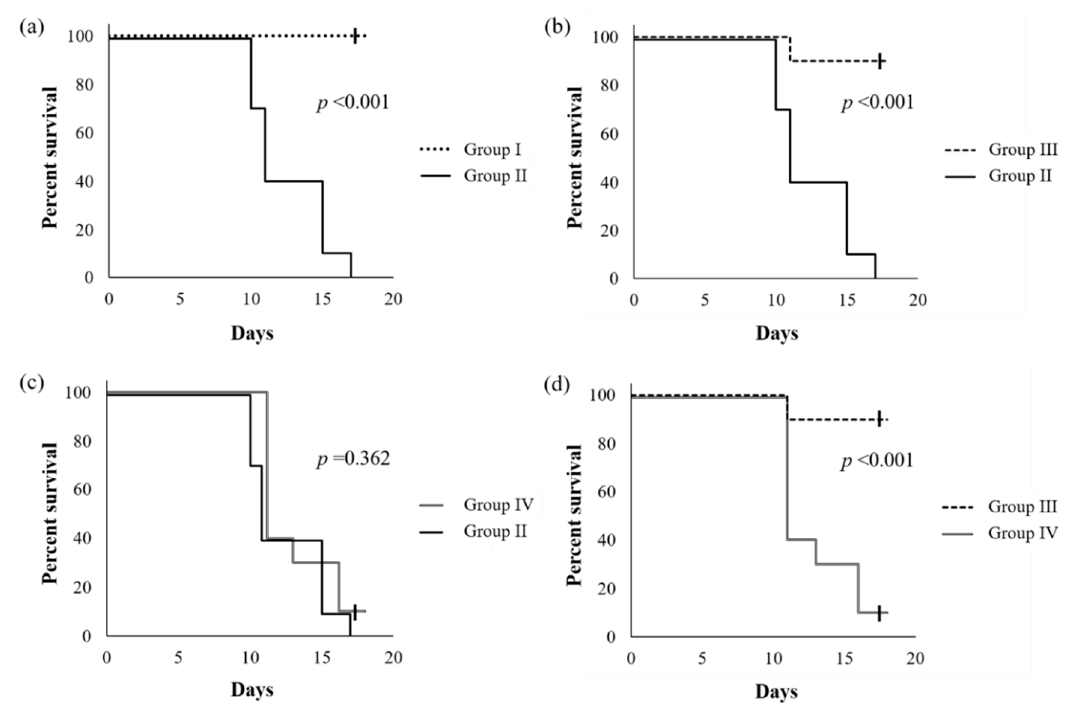
Figure 1. The Kaplan–Meier survival curves of C57BL / 6J mice fed an ethanol-containing diet with or without the addition of live SN13T cells. The group fed without ethanol was also compared. The p -values were calculated using the log-rank test. Group I, which was fed only an L10015 diet without the administration of ethanol; group II, which was fed an L10016 diet with ethanol; groups III and IV, which were fed with the simultaneous administration of ethanol and the live or heat-killed SN13T cells, respectively, in the L10016 diet. Each graph shows the comparison of survival rate (%) between Groups I and II ( a ), II and III ( b ), II and IV ( c ), and III and IV ( d ), respectively.